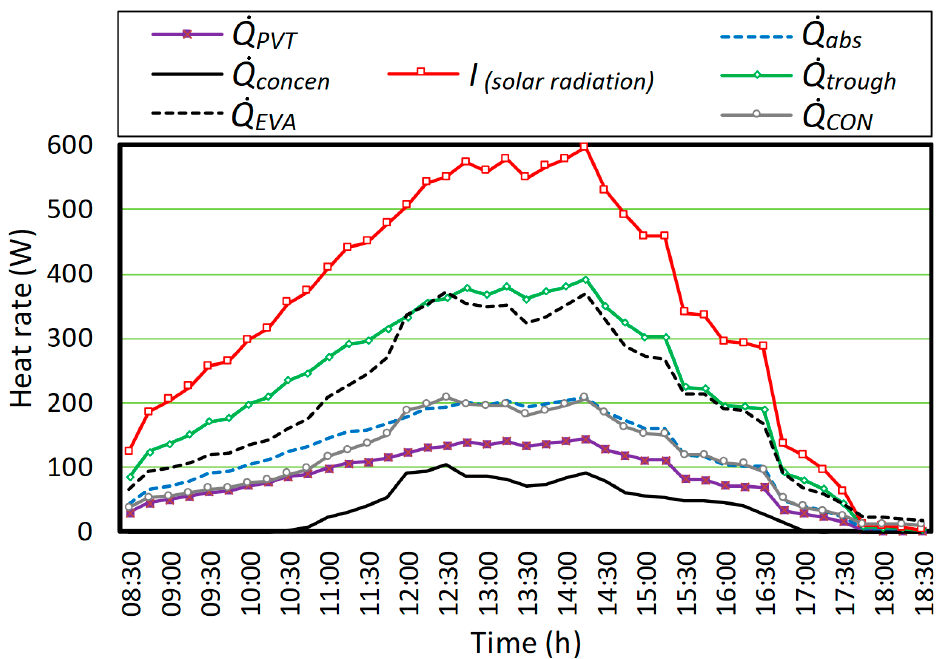
Figure 10. Changes in the heating rate for some components of the HP-CPVT system.